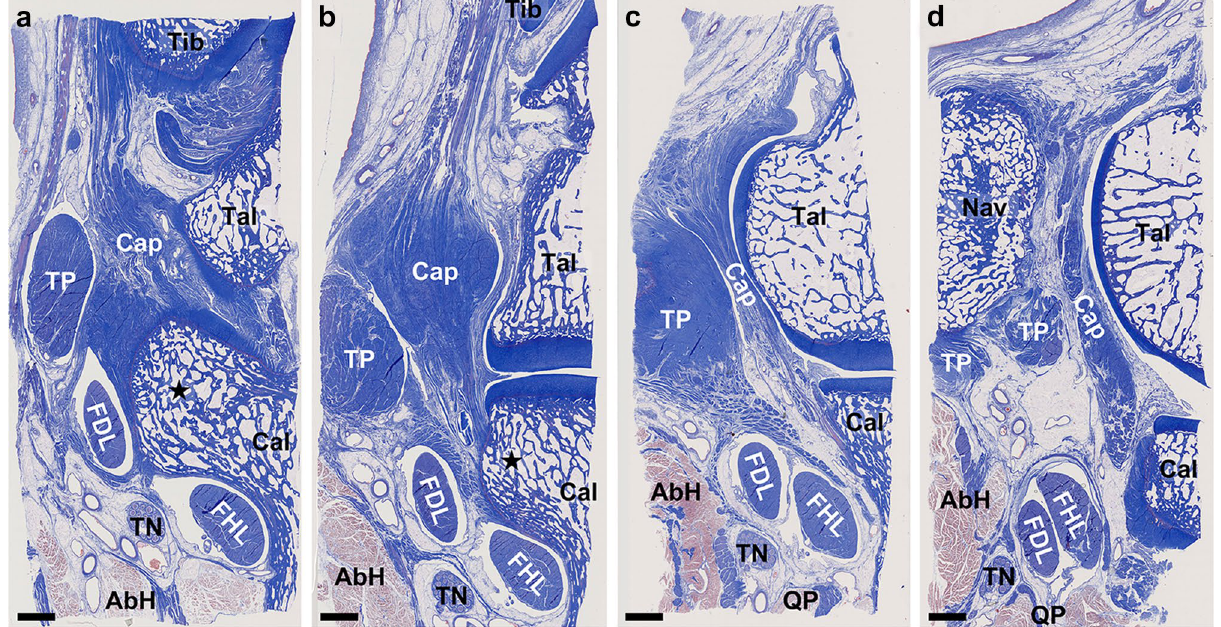
Figure 4. Histological analysis of the ankle joint capsule complex with flexor tendons (Masson’s trichrome staining). Histological sections of the boxed region in Fig. 3c–f are shown in ( a – d ). The flexor digitorum longus (FDL) locates inferomedial to the sustentaculum tali (star) ( a , b ). Its tendinous sheath, composed of dense connective tissue, attaches from posterior ( a ) to anterior ( b ) part of the sustentaculum tali, in complex with the joint capsule (Cap). Its sheath is partly connected to the tibialis posterior (TP) at the anterior edge of the sustentaculum tali ( c ) and is separated from the TP by loose connective tissue anterior to the sustentaculum tali ( d ). AbH abductor hallucis, Cal calcaneus, FHL flexor hallucis longus, Nav navicular, Tal talus, Tib tibia, TN tibial nerve, QP quadratus